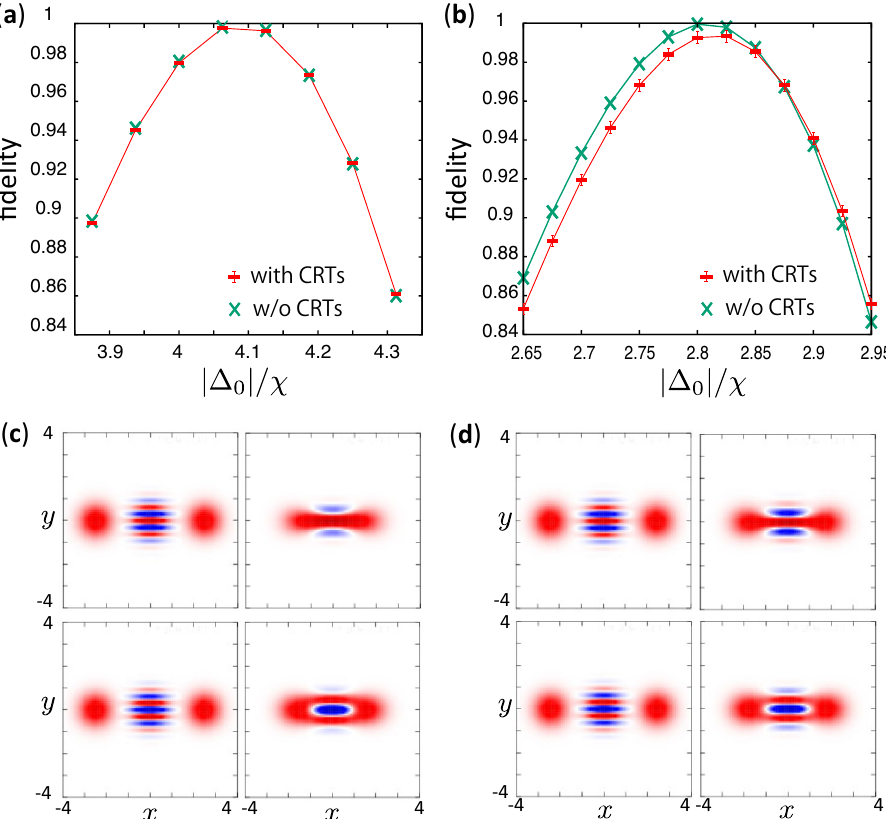
53 MHz, χ/ 2 π 17 MHz for ( a ) and Figure 6. Fidelity of R x ( π 2 ) gate. The used parameters are β/ 2 π = = 2 π 16 GHz and T 100 ns for the both panels. 200 MHz, χ/ 2 π 68 MHz for ( b ). We used ω β/ 2 π p / g = = = = The error bars represent the standard deviation calculated using the data for t > T g . ( c ) and ( d ): Wigner function of the highest (upper panels) and the second highest levels (lower panels) of H RWA in Eq. (5). The left 0 and (cid:31) 4.1 for ( c ) and 2.8 for ( d ), respectively. (cid:31) 0 , where � 0 /χ and the right panels correspond to (cid:31) = = | | = The other parameters used in ( c ) and ( d ) are the same as ( a ) and ( b ),